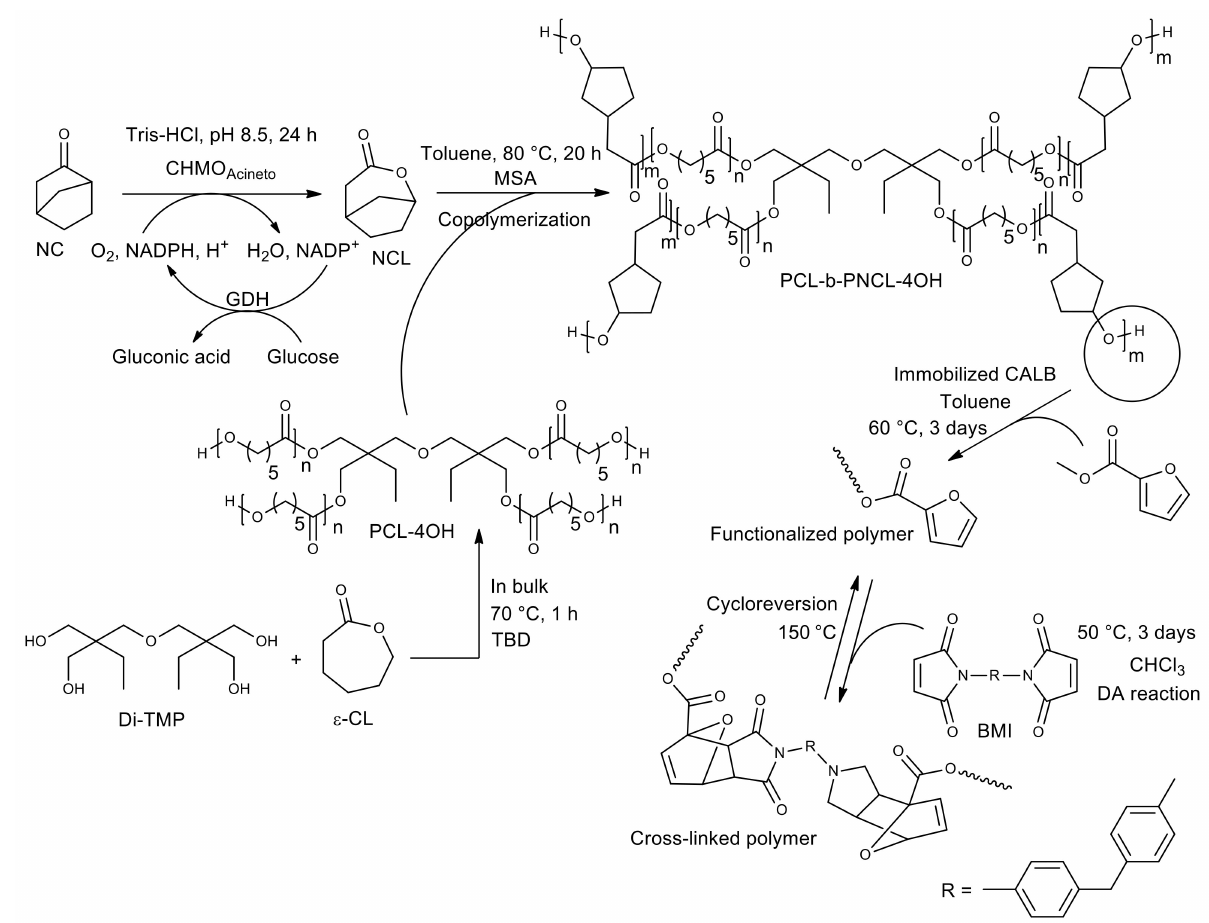
Figure 17. Chemoenzymatic synthesis of thermosensitive polymers based on star-like polyesters. NC—norcamphor, NCL— norcamphor lactone, CHMOAcineto—cyclohexanone monooxygenase from A. calcoaceticus , GDH—glucose dehydrogenase, Di-TMP—di-trimethylolpropane, ε -CL— ε -caprolactone, TBD—1,5,7-triazabicyclo[4.4.0]dec-5-ene, MSA—methanesulfonic acid, PCL—polycaprolactone, PNCL—poly(norcamphor lactone), CALB—lipase B from Candida antarctica , BMI—1,1 (cid:48) - (methylenedi-4,1-phenylene)-bis-maleimide,